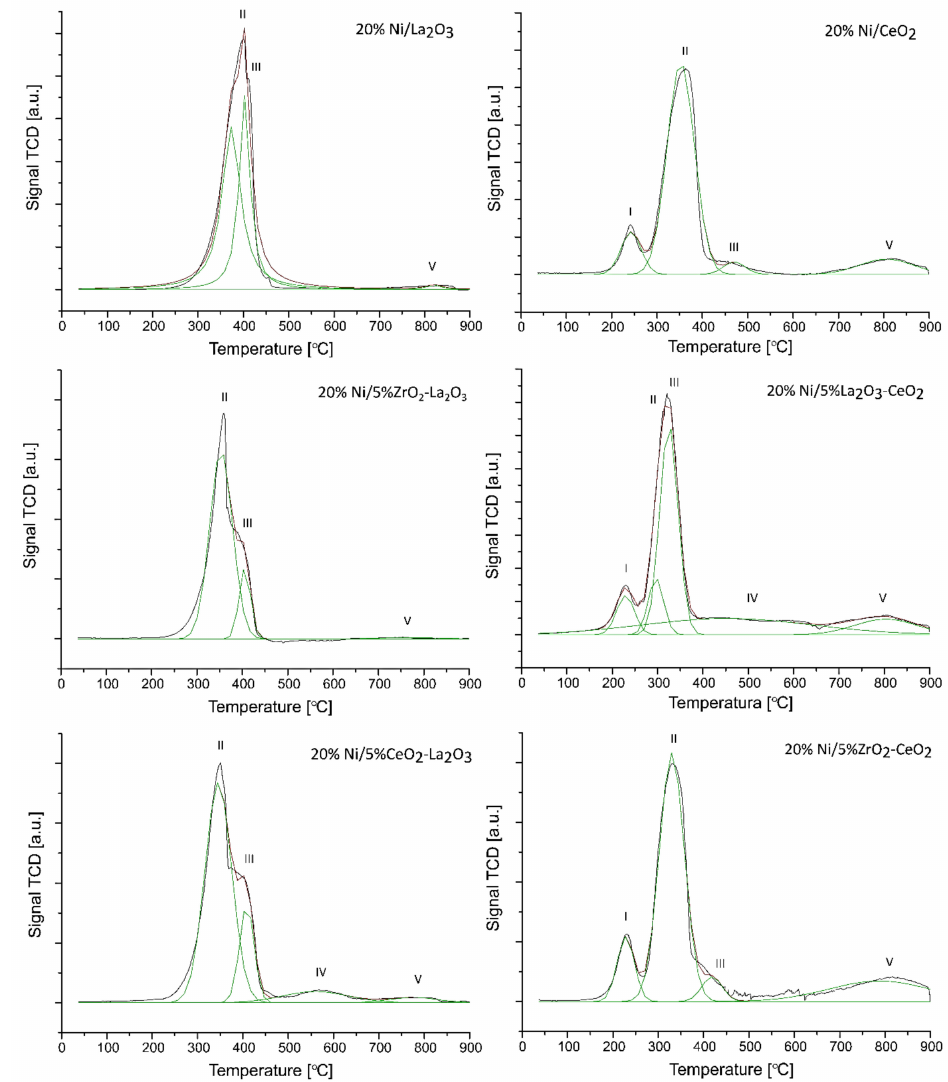
Figure 7. TPR-H 2 profiles of nickel catalysts calcined at 400 ◦ C in an air atmosphere for 4